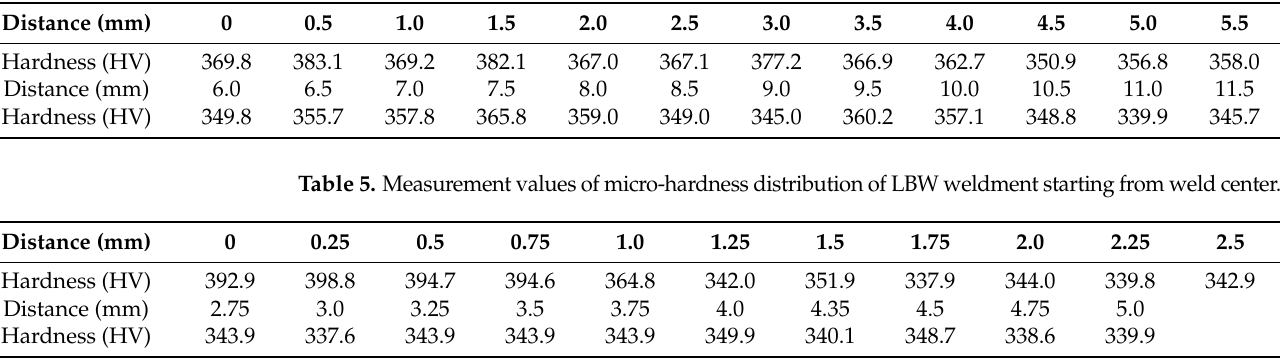
Table 4. Measurement values of micro-hardness distribution of TIG weldment starting from weld center.